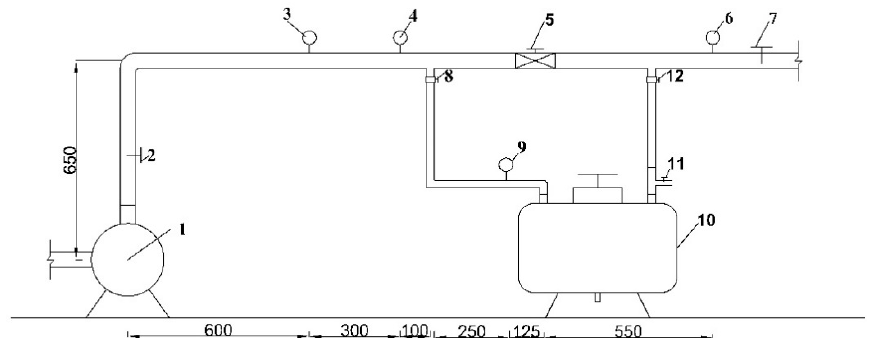
Figure 8. Layout of the experiment site for testing the fertilization uniformity of the pressure di ff erential tank. (unit: mm). 1. Pump 2. Valve 3. Flowmeter 4. Pressure gauge 5. Pressure regulating valve 6. Pressure gauge 7. Valve 8. Valve 9. Flowmeter 10. Pressure di ff erential tank 11. Sampling point 12. Valve.